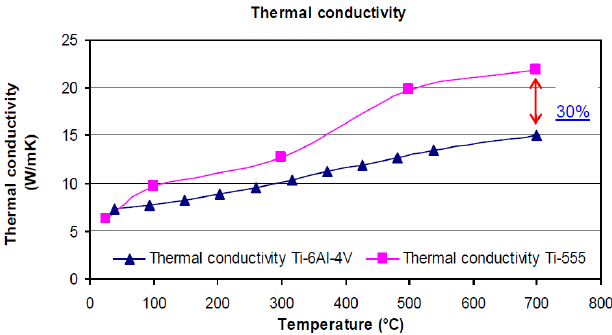
Figure 4. Evolution of thermal conductivities of Ti-55531 and Ti-6Al-4V with cutting